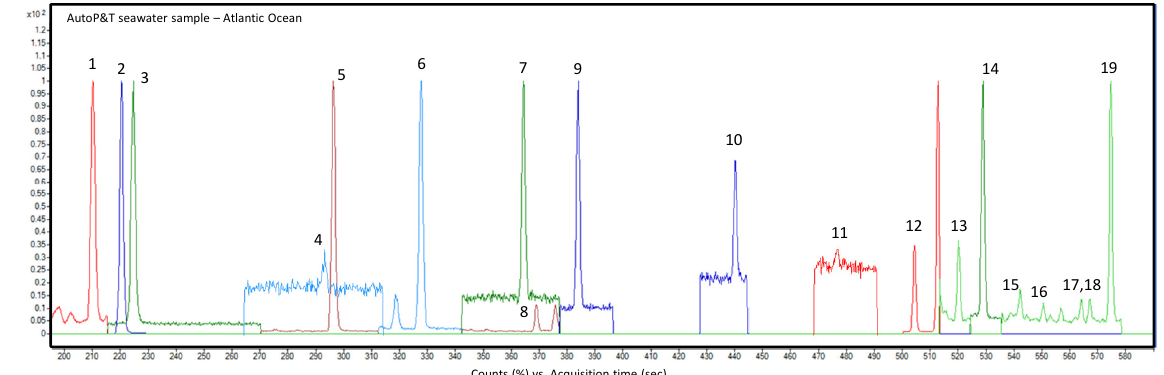
Figure 2. Example Atlantic Ocean seawater chromatogram obtained using the AutoP&T with extracted ions individually scaled. Compound names of peak labels are listed in Table 1.